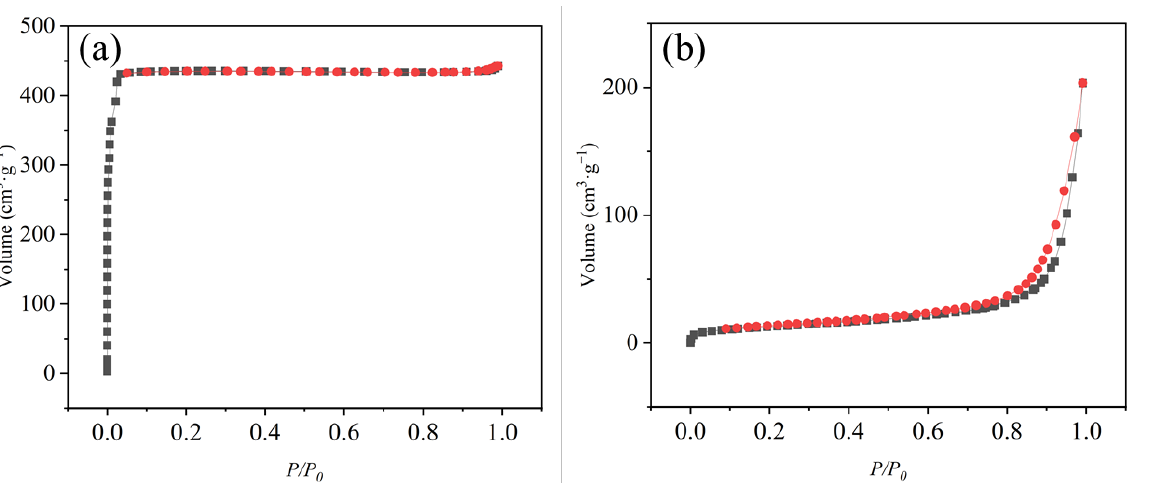
Figure 6. N 2 adsorption−desorption isotherms of ( a ) ZIF-8 ( b ) ZnBTC.